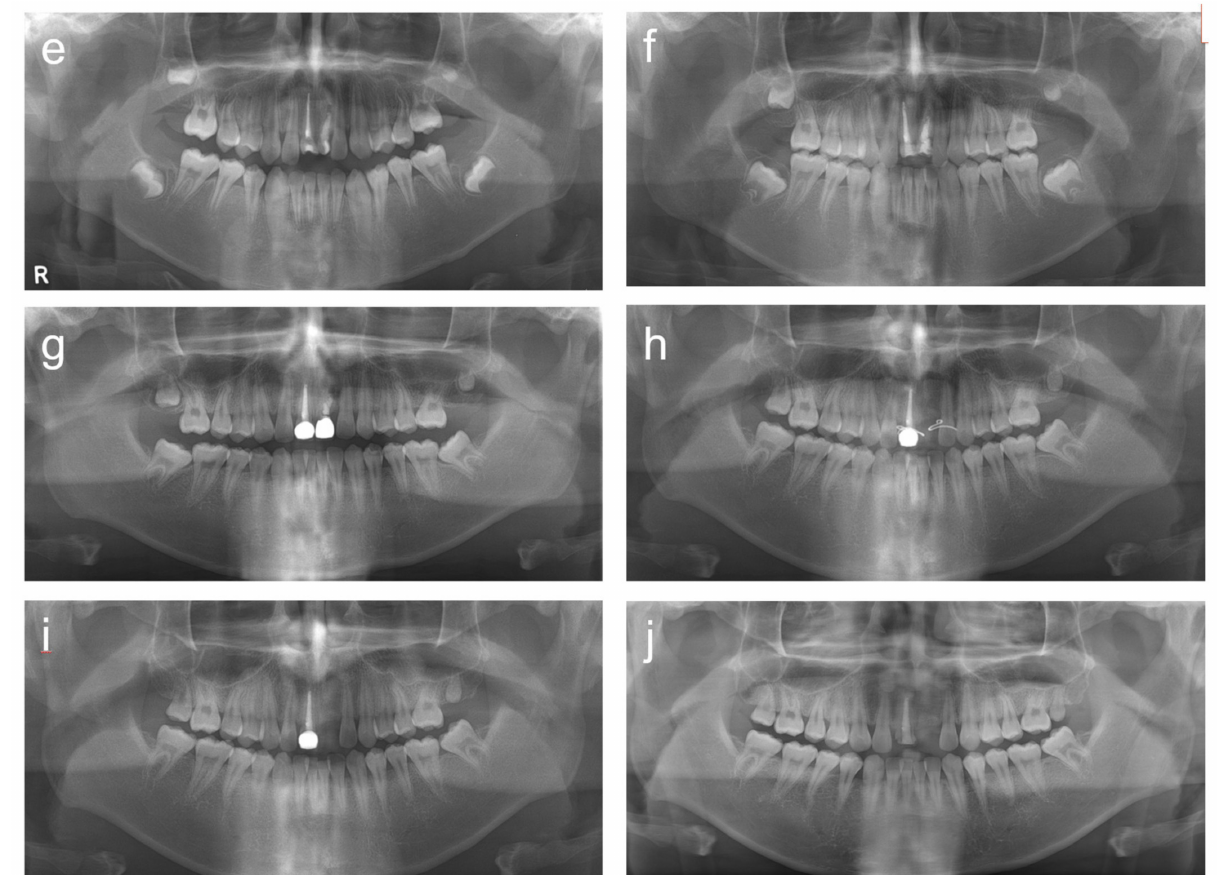
Figure 1. Panoramic radiographs of patient 1. ( a ) Panoramic radiograph at age 8 years 4 months. ( b ) Panoramic radiograph at age 9 years 5 months. ( c ) Panoramic radiograph at age 9 years 7 months. ( d ) Panoramic radiograph at age 10 years 5 months. ( e ) Panoramic radiograph at age 11 years 3 months. ( f ) Panoramic radiograph at age 13 years 2 months. ( g ) Panoramic radiograph at age 15 years 5 months. ( h ) Panoramic radiograph at age 16 years 7 months. ( i ) Panoramic radiograph at age 17 years 9 months. ( j ) Panoramic radiograph at age 19 years 1